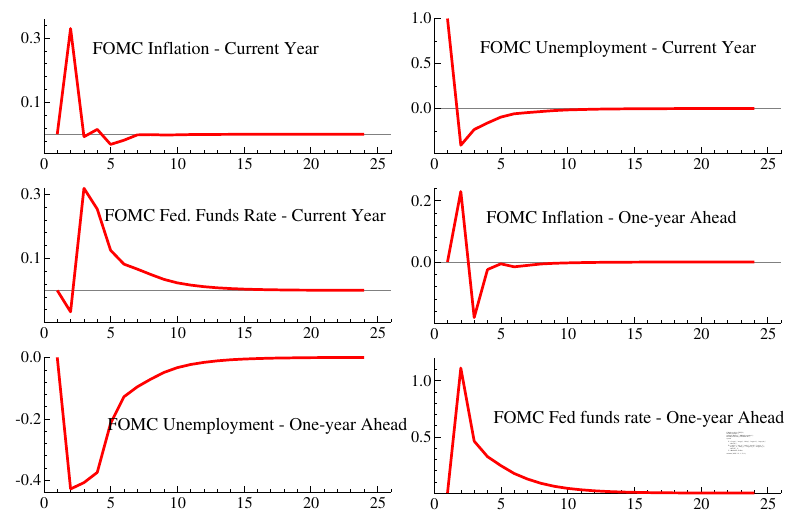
Figure 10. Impulse Responses to a one-percent unemployment